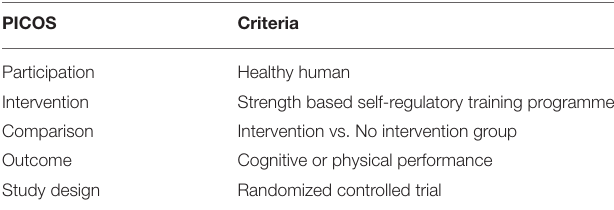
TABLE 1 | PICOS (participation, intervention, comparison, outcome, and study design). PICOS